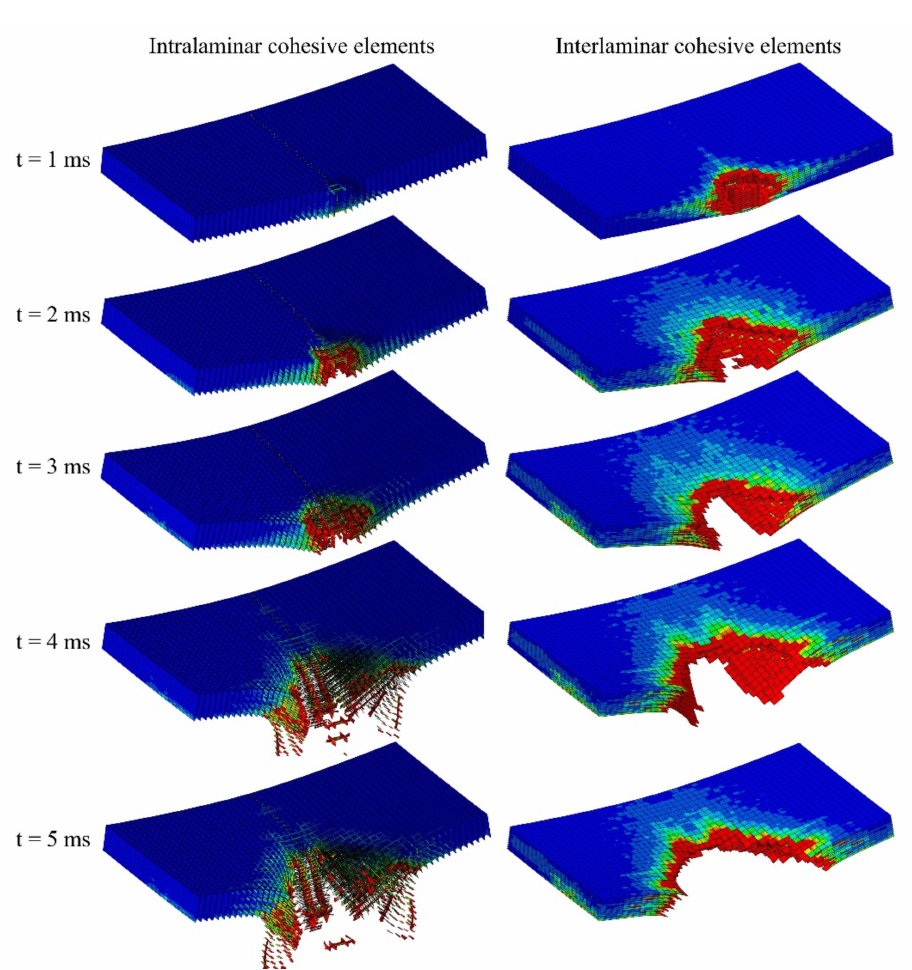
Figure 13. The progressive damage of intralaminar and interlaminar cohesive elements of the CD model. The blue colour indicates no damage, and the red colour indicates a fully damaged